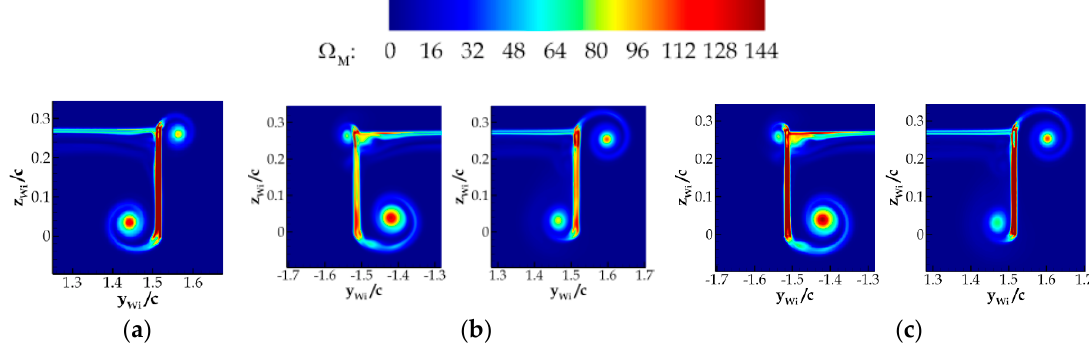
Figure 27. Contours showing the mean vorticity magnitude of the endplate vortices at x Wi /c = 1.019. ( a ) Straight-line condition; ( b ) Cornering condition; ( c ) Fixed yaw condition.